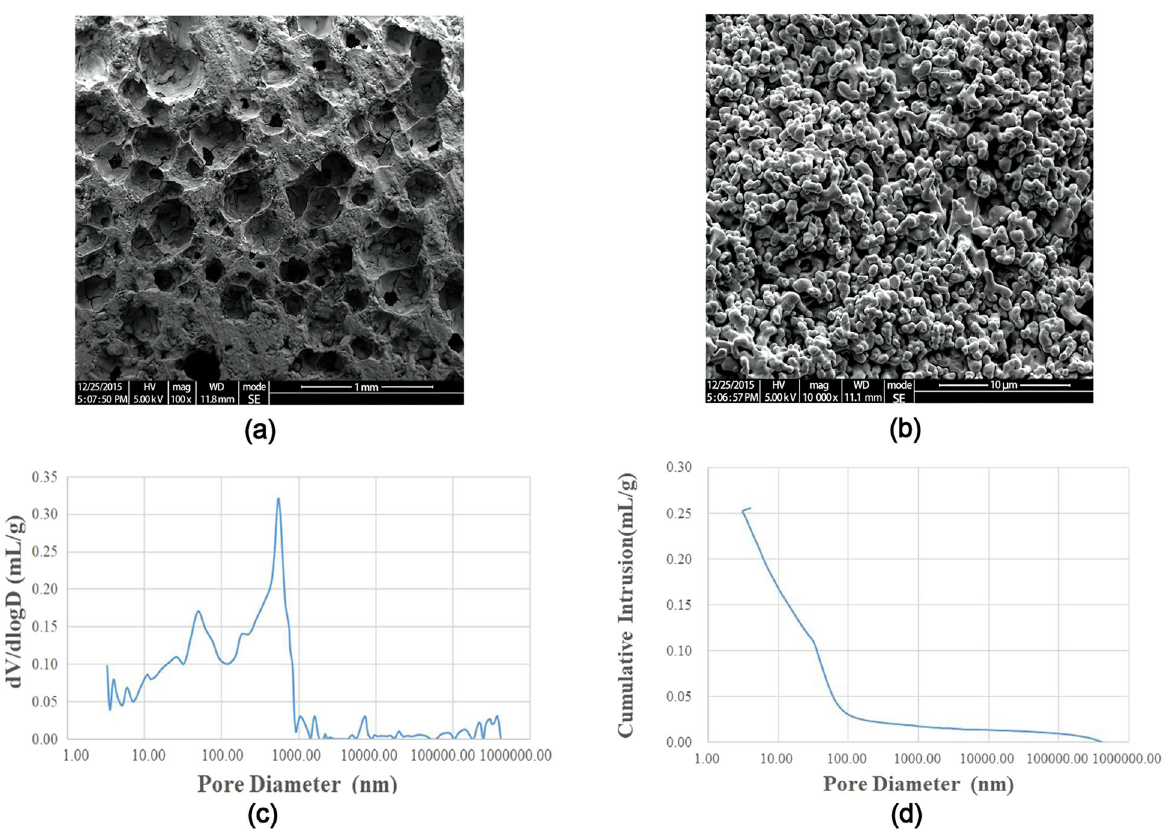
Fig. 1 SEM images of BCP ceramics. The magni fi cation was ×100 ( a ) and ×10,000 ( b ). Pore size distribution ( c ) and cumulative intrusion ( d ) of BCP obtained by mercury intrusion porosimetry